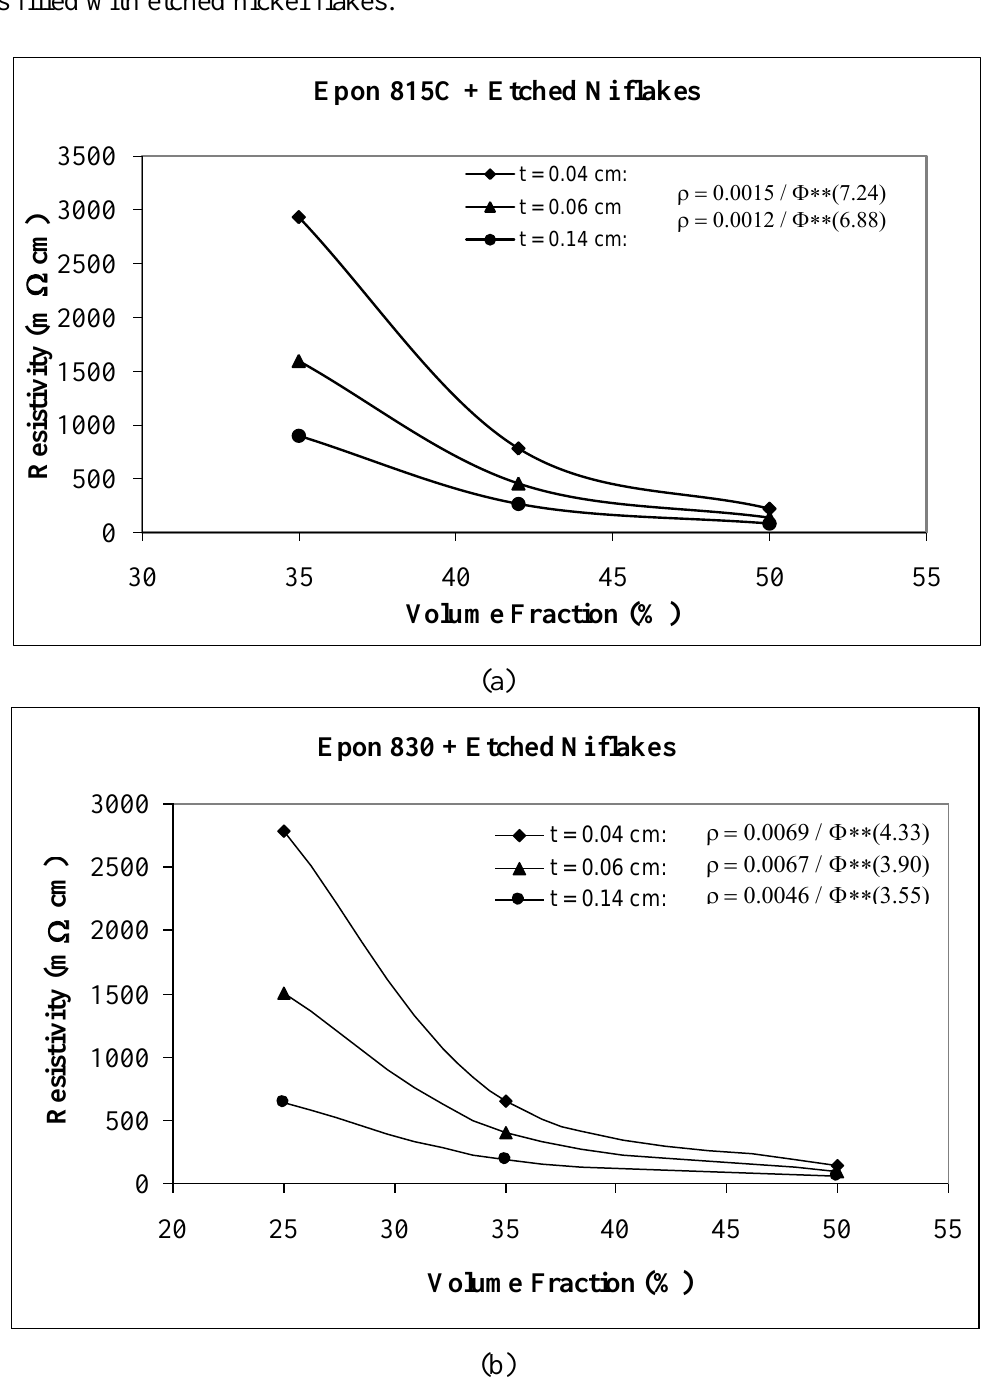
Figure 13. Volume fraction-thickness dependent resistivity of Epon 815C ( a ), and 830 ( b ) films filled with etched nickel